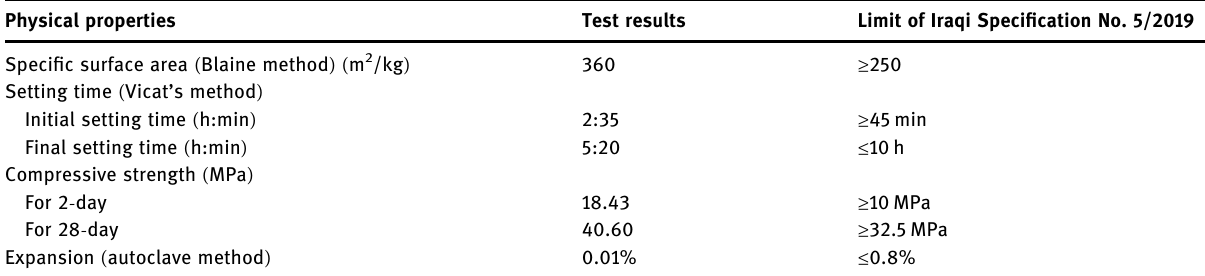
Table 1: Physical properties of the considered cement Physical properties Test results